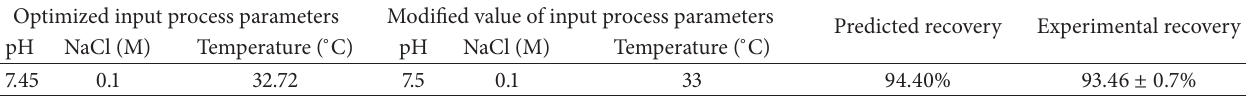
Table 8: Experimental verification of the